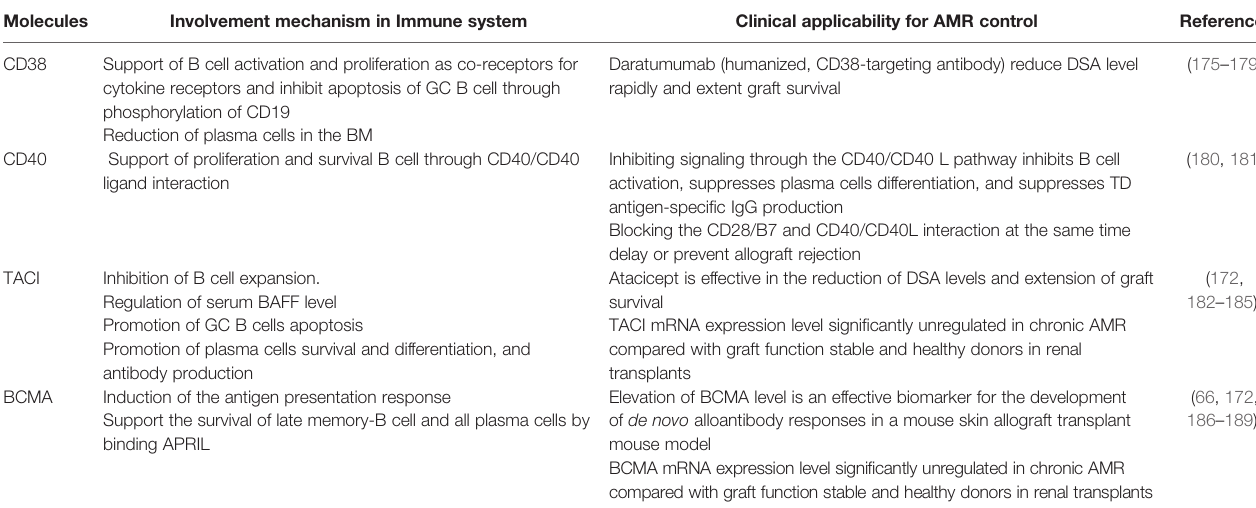
TABLE 2B | Molecules expressed by B cells and clinical applicability for AMR